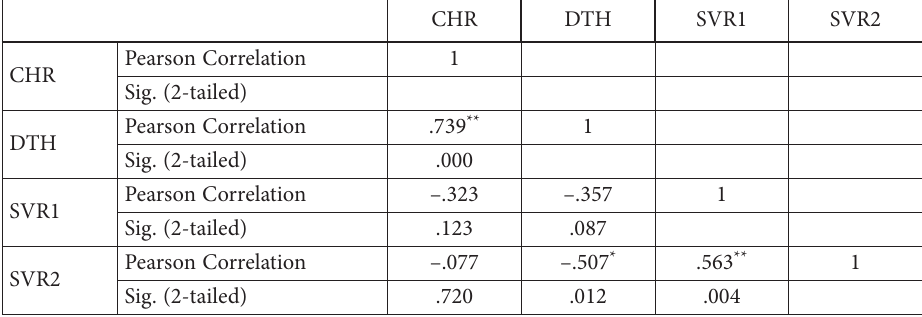
Table 14. Values of bilateral correlations between factorial variables in Cluster C CHR DTH SVR1 SVR2 Pearson Correlation 1 CHR Sig. (2-tailed) Pearson Correlation .739 ** 1 DTH Sig. (2-tailed) .000 Pearson Correlation –.323 –.357 1 SVR1 Sig. (2-tailed) .123 .087 Pearson Correlation –.077 –.507 * .563 ** 1 SVR2 Sig. (2-tailed) .720 .012